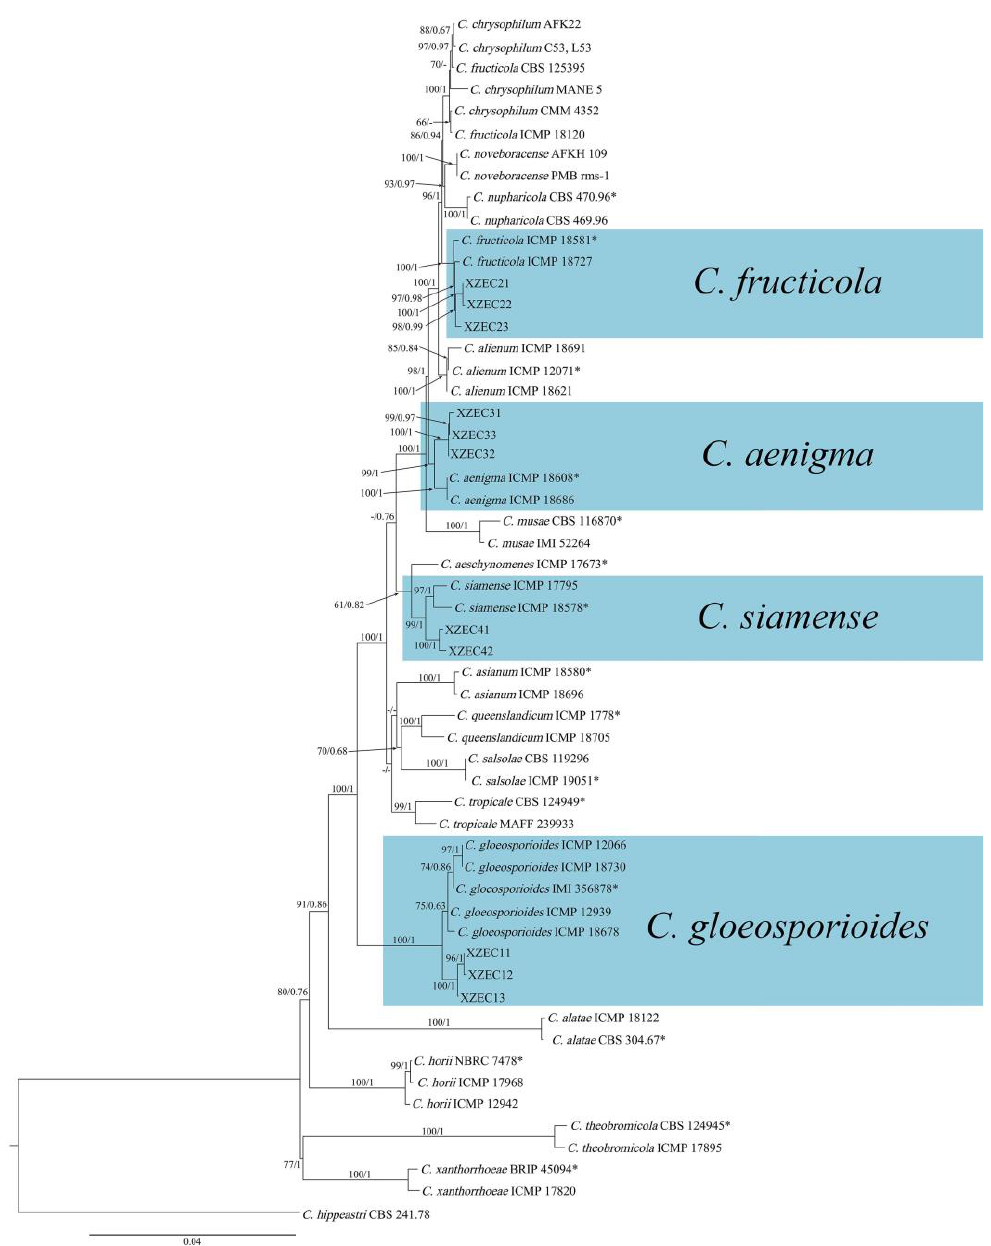
Figure 7. Phylogenetic tree generated with the concatenated sequences of the ITS, ACT, ApMat, CAL, CHS−1, GAPDH, GS, and TUB2 genes using maximum likelihood analysis. The tree generated by Bayesian inference had a similar topology. Bootstrap support values above 60% (before the slash marks) and Bayesian posterior probabilities above 0.60 (after the slash marks) are given at each node (BP/BPP). Colletotrichum hippeastri (CBS 241.78) was used as an outgroup. Ex-type strains are marked with (*).